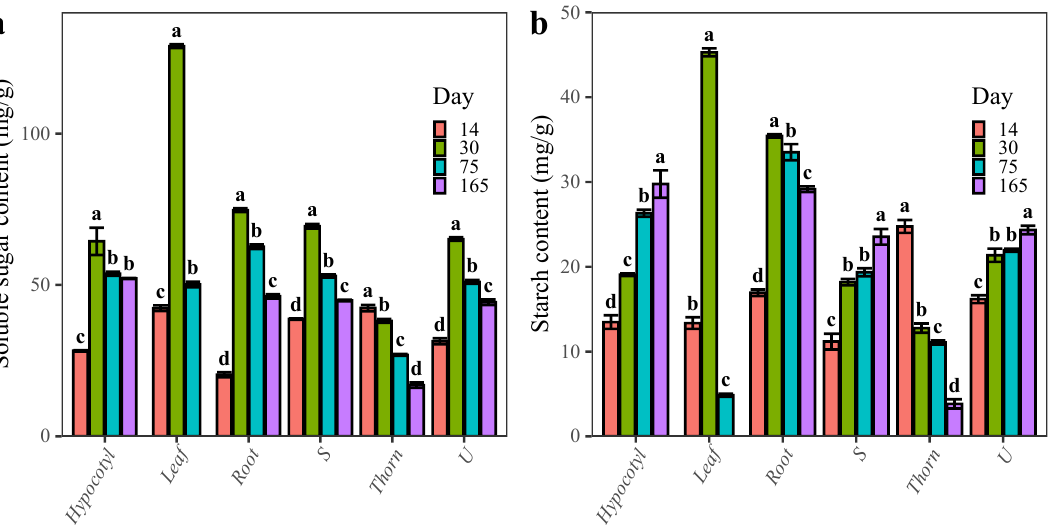
Figure 1. Changes in the physiological index content of ZJC development. ( a ): soluble sugar content; ( b ): starch content. Note: The data were analyzed by one-way analysis of variance (ANOVA) by R, different letters indicate the significant differences ( p < 0.05, LSD) between means. The bars represent the mean ± SD. There was no leaf data because the leaves fall off when the seedlings of G. sinensis were